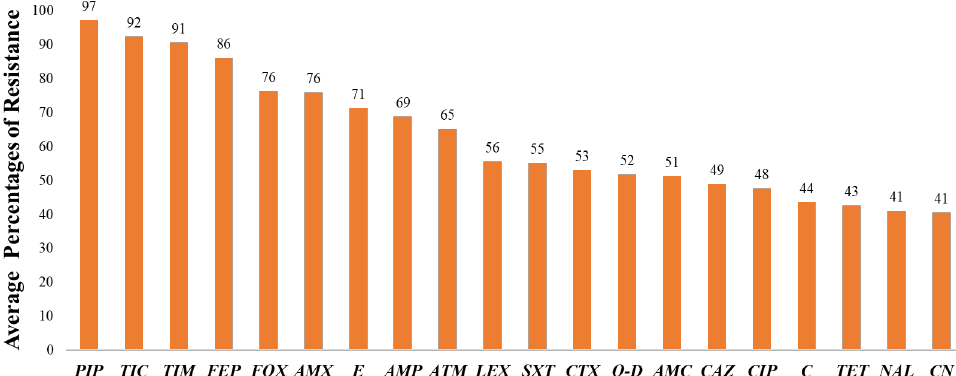
Figure 3. Major antibiotic resistance of Gram-negative bacteria in bats. Piperacillin = PIP, Ticarcillin = TIC, Ticarcillin-clavulanic acid = TIM, Cefepime = FEP, Cefoxitin = FOX, Amoxicillin = AMX, Erythromycin = E, AMP = Ampicillin, Aztreonam = ATM, Cephalexin = LEX, Cefotaxime = CTX, Quinupristin-dalfopristin = Q-D, Amoxicillin-Clavulanic acid = AMC, Ceftazidime = CAZ, Ciprofloxacin = CIP, Chloramphenicol = C, Tetracycline = TET, Nalidixic acid = NAL, Gentamicin = CN.